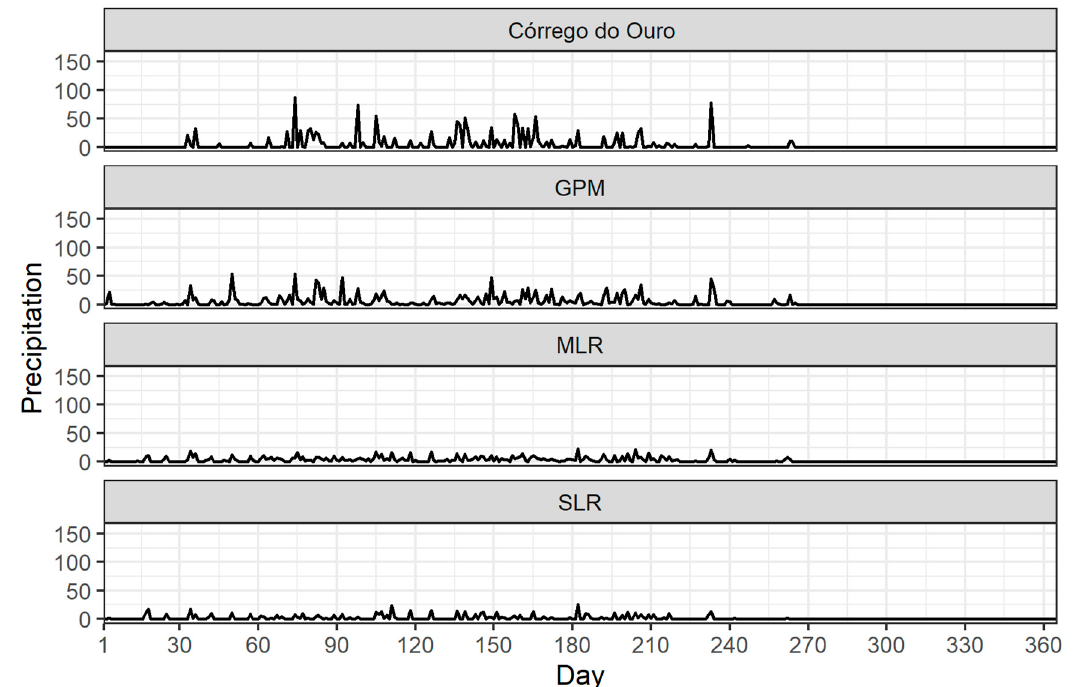
Figure 6. Direct comparisons between daily precipitation estimates and observed data for the period from 1 September 2016 to 31 August 2016 at the Córrego do Ouro station. OBS, observed data; MLR, multiple linear regression method; SLR, simple linear regression; GPM, Global Precipitation Measurement method.